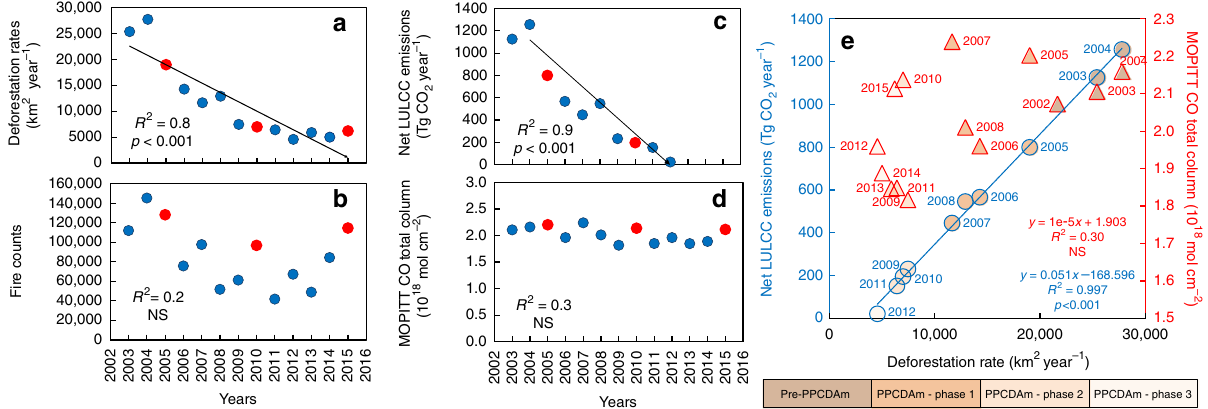
Fig. 4 Annual trends in deforestation and forest fi re-associated carbon emissions in the Brazilian Amazon. Linear trends (2003 – 2015) of annual a deforestation rates, b active fi res counts, c reported Brazilian net land use and land cover change-related CO 2 emission estimates 4 (Net LULCC emissions) and d Measurements of Pollution in the Troposphere (MOPITT) CO total column data. Red circles indicate the analyzed drought years. Linear trends (black lines) are shown for statistically signi fi cant data. In a – d R 2 is the coef fi cient of determination, p is the probability calculated at 95% con fi dence level and NS indicate non-signi fi cant trends. The relationship between the Net LULCC emissions and MOPITT CO total column with deforestation rates are shown in e . Symbols are grouped with different colours to separate the years according to four PPCDAm